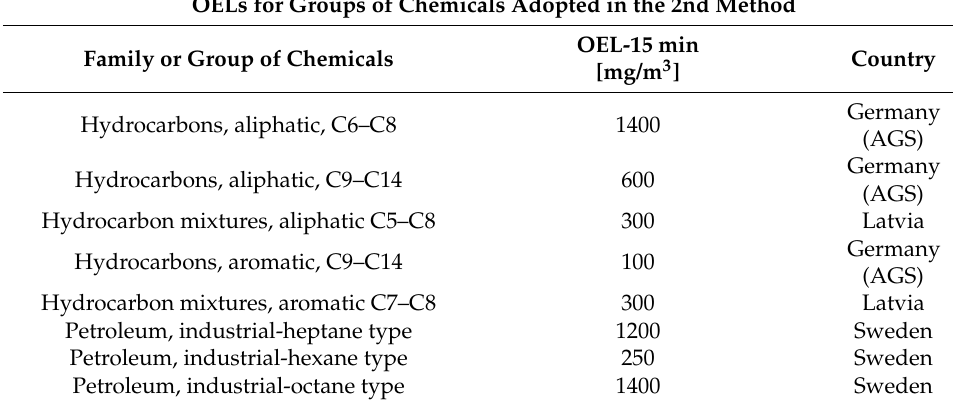
Table 1. ELs adopted in the 2nd method for family/group of chemicals.